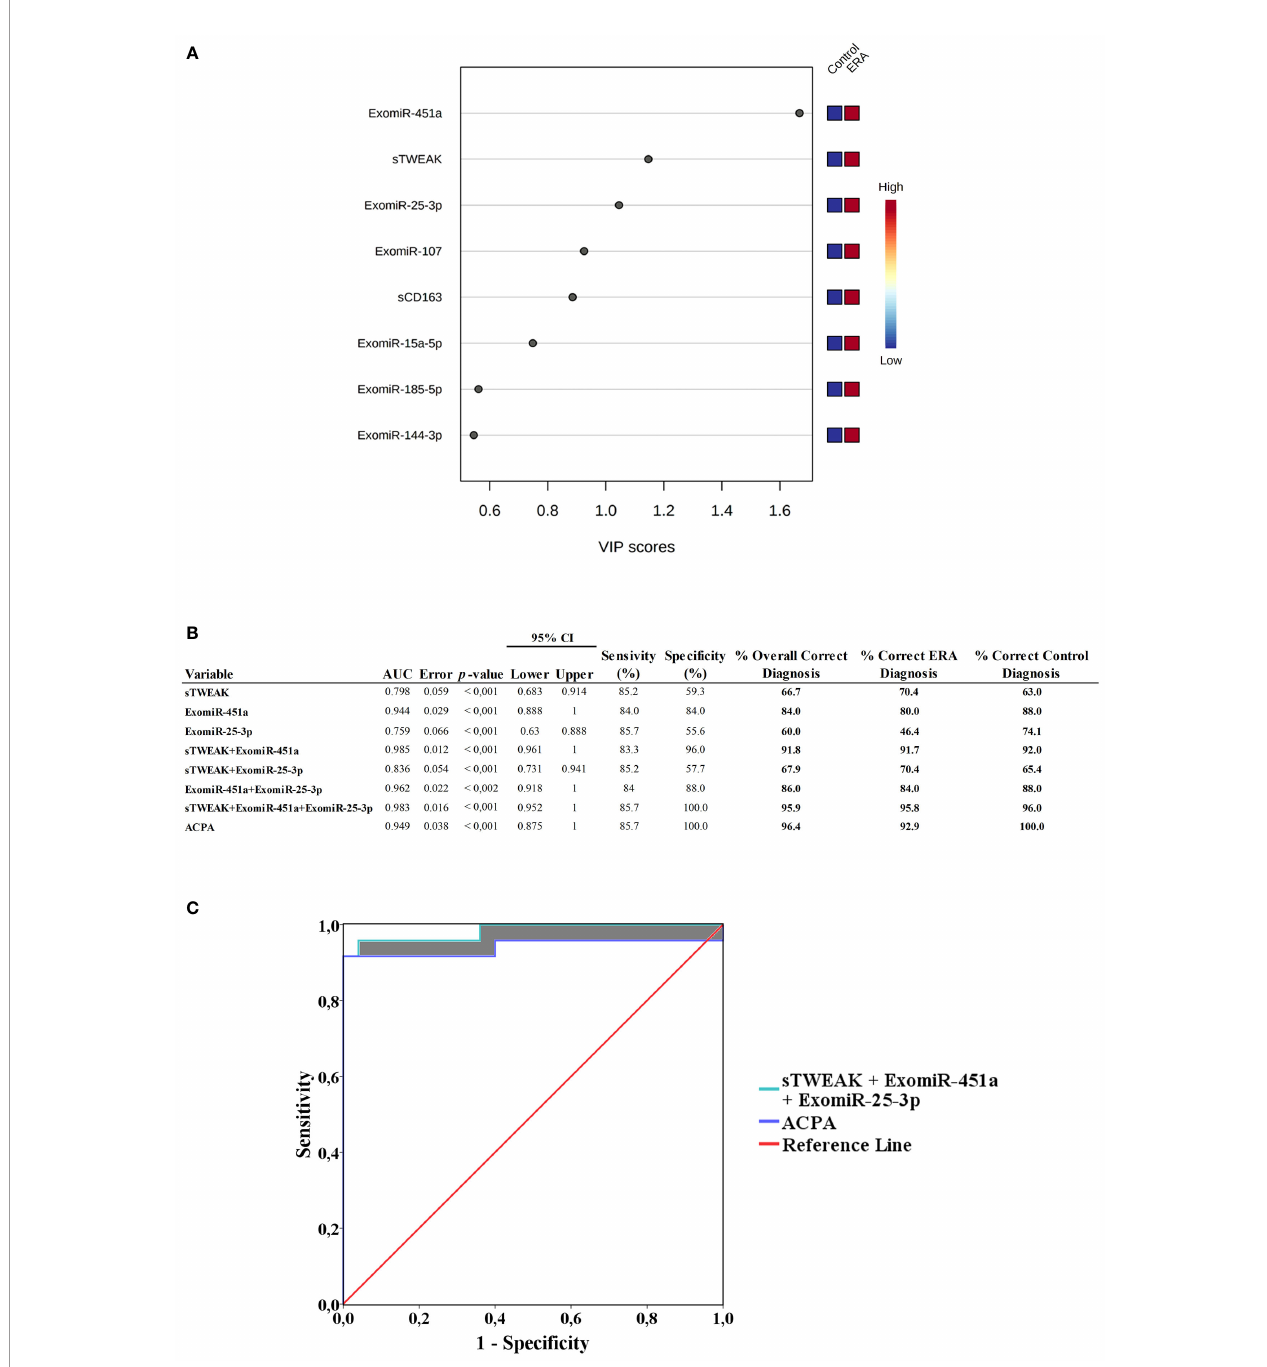
FIGURE 5 | (A) Variable importance in projection (VIP) analysis, showing importance of each selected signature in discriminating between cohorts. Red squares indicate high expression and blue squares low expression (B) Receiver operating characteristic (ROC) curve values showing the predictive ef fi ciency for distinguishing early RA from healthy controls. Percentage of correct diagnostic values was obtained by univariate models. AUC, area under the curve; 95% CI (con fi dence interval). (C) ROC area comparations. ROC area from ACPA was compared with ROC from sTWEAK + exomiR-451a + exomiR-25-3p. Shaded areas show ROC AUC